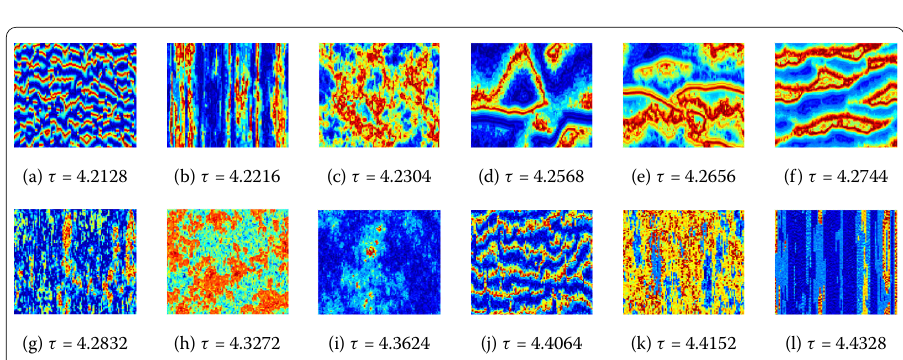
Figure 5 Pattern self-organization and transition with τ value ranging in [4.16,4.44]. Various striped patterns, circled patterns, and disordered patterns are demonstrated. The conditions for pattern simulations are exactly the same as those in Fig.